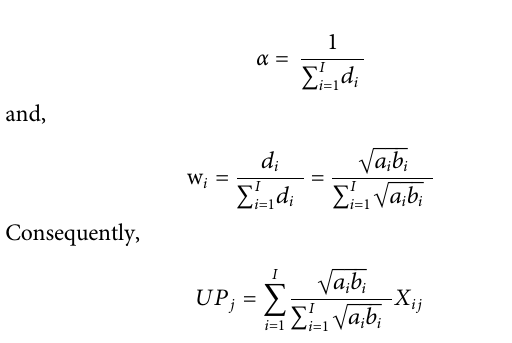
Frontiers in Built Environment |